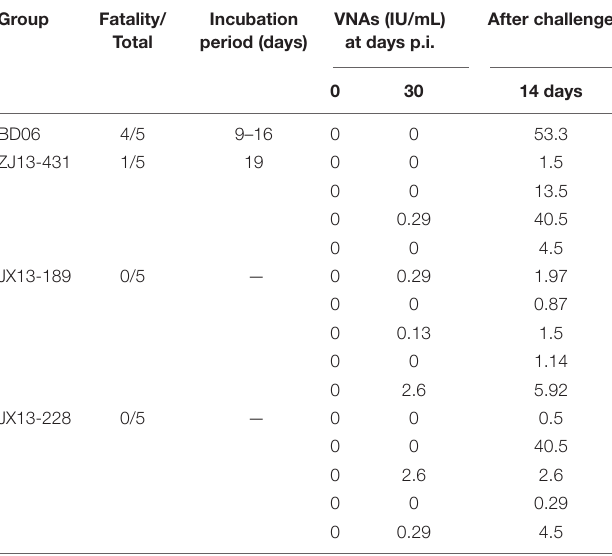
TABLE 3 | Rabies virus neutralizing antibody titers (IU/ml) and mortality of beagles post infection (p.i.). Group